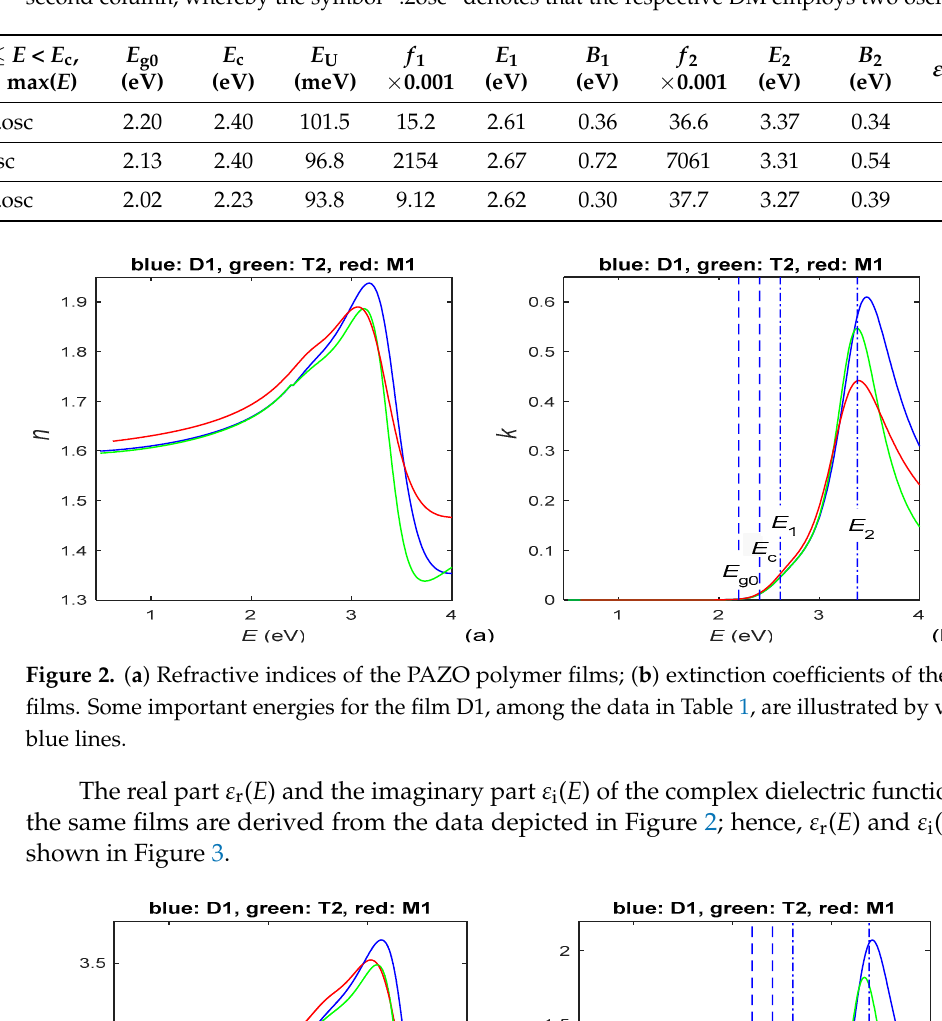
6 of 12 Figure 1. ( a ) Photos of the PAZO polymer samples; ( b ) Measured transmittance spectra of these samples. 3.1. Results from Characterizations of the PAZO Polymer Films Using HDM and T( λ ) The PAZO polymer films are characterized, using HDM, only from T ( λ ) of the sam- ples. With respect to this, it is seen from Figure 1b that T ( λ ) of the sample M1 includes absorption around λ ~ 350 nm, which is below λ for the absorption edge. Accordingly, the HDM characterizations employ two oscillators. Values of the DM parameters regarding n ( λ ) and k ( λ ), obtained via the HDM characterizations of these films, are shown in Table 1. In Table 1, f i is the strength of the “i”-th oscillator, E i is its central energy and B i is its energy broadening, as the subscript “1” refers to the lower energy oscillator and the sub-